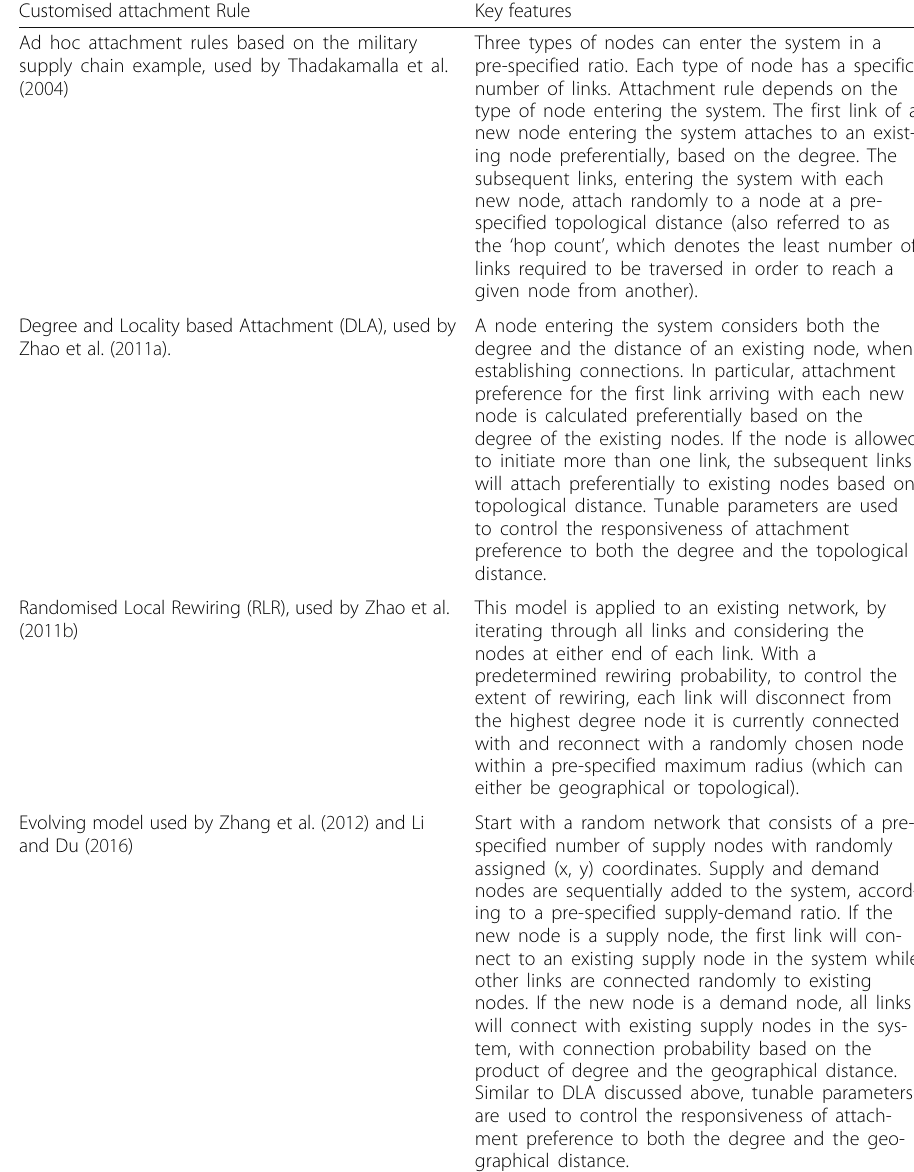
Table 2 Key features of customised attachment rules used in literature Customised attachment